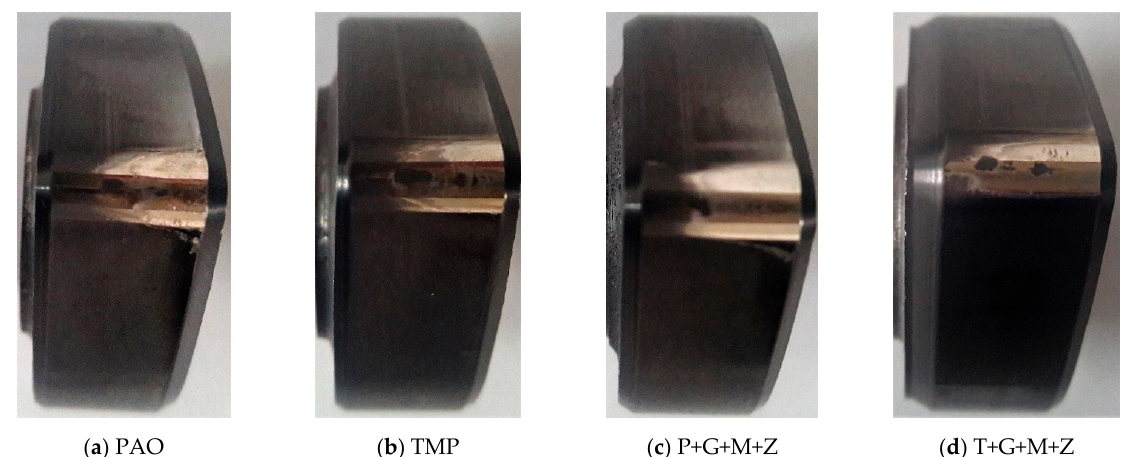
Figure 18. Optical images of a-C:H:W-coated camlobes after cylinder head testing in combination with a-C:H:W-coated tappets under various conditions in the presence of TMP-based and PAO-based lubricants.